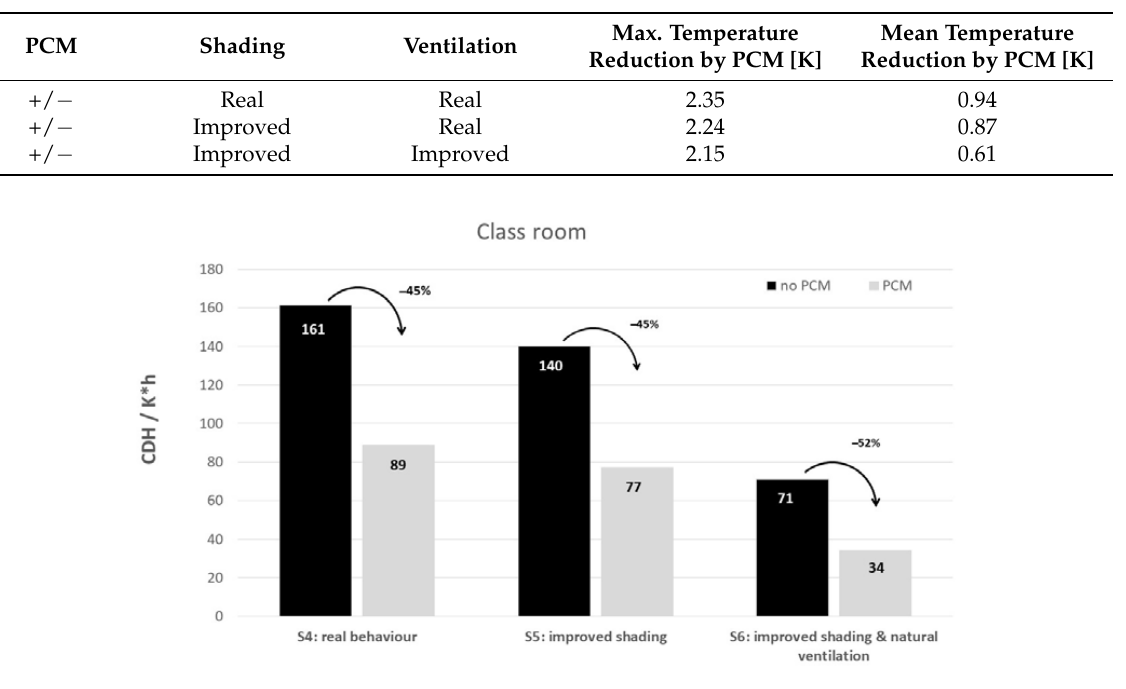
Figure 11. Effect of PCM on periods of thermal discomfort from June through September.